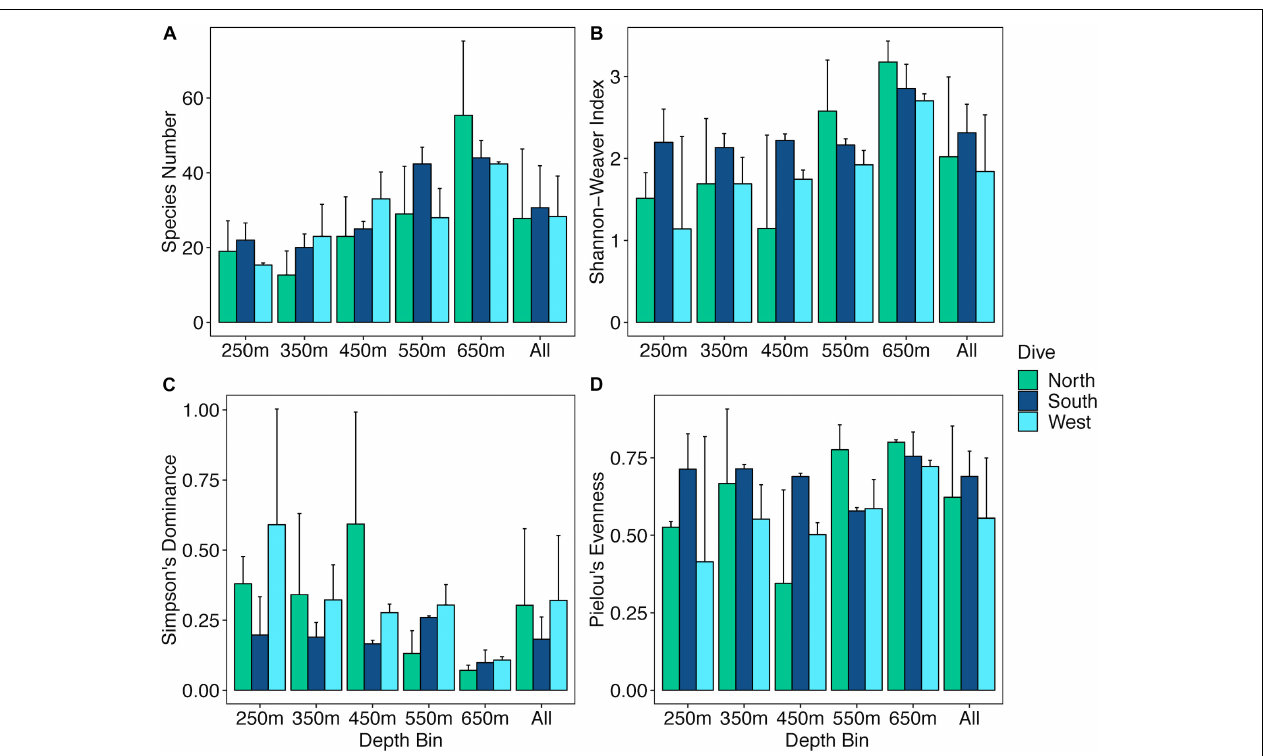
FIGURE 8 | Bar plots of diversity metrics for three slopes of Mokumanamana by depth. Panels: (A) species richness, (B) Shannon-Weaver’s Index, (C) Simpson’s Dominance Index, (D) Pielou’s Evenness Index.